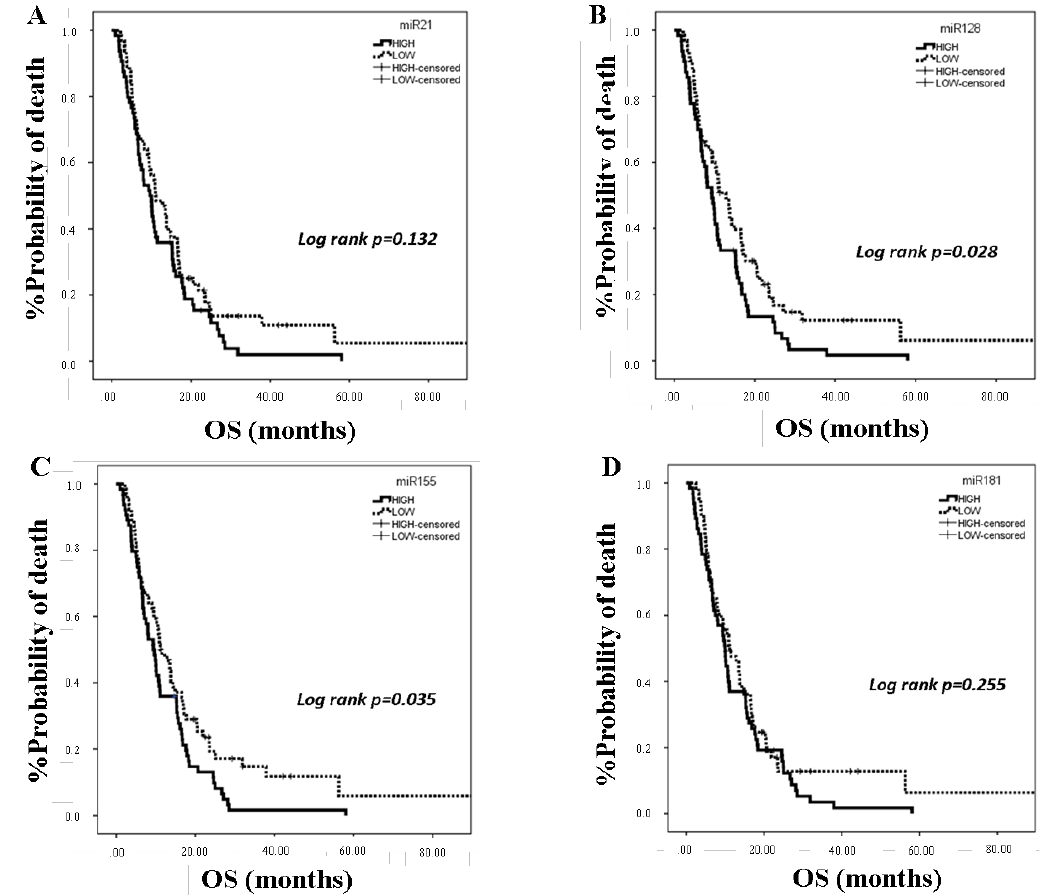
Figure 3. Kaplan Meier analysis for overall survival (OS) according to miRNA expression in the plasma of NSCLC (n = 128). Patients were classified into high and low expression groups according to the median value of each miRNA. OS in patients with high or low expression of miR-21 ( A ), miR-128 ( B ), miR-155 ( C ), and miR-181a ( D ). Curves were compared using the log rank test. p values are shown. Univariate Cox regression analysis revealed that PS 2 ( p = 0.001), the presence of 2 or more metastatic sites ( p = 0.006), high miR-128 ( p = 0.03), and high miR-155 ( p = 0.036) were associated Table 3. Univariate and multivariate Cox regression analysis for overall survival in NSCLC patients.